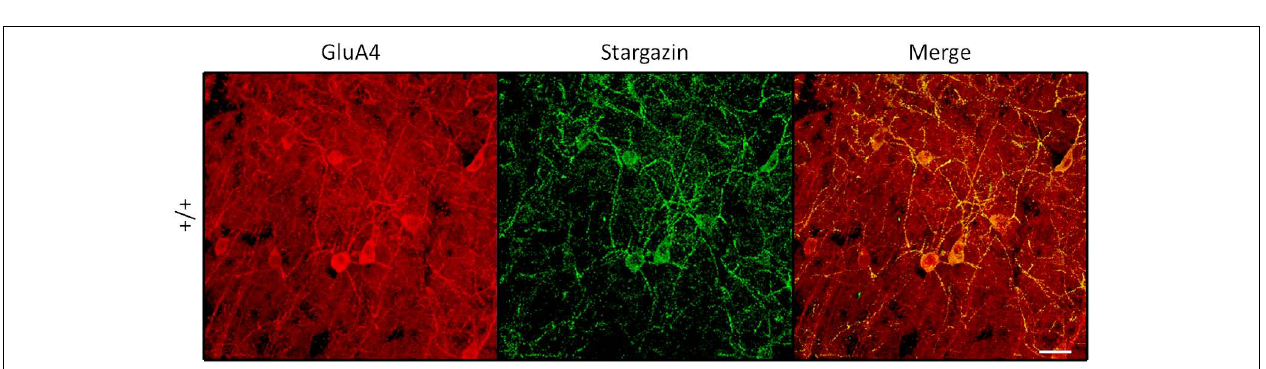
FIGURE 3 | Regional variation in stargazin immunoreactivity. In the hippocampal CA1 region, both PV + interneurons and pyramidal neurons (arrow) can express stargazin, whereas in frontal and occipital cortex, as in somatosensory regions, stargazin expression is limited to PV + /TdT + interneurons (scale = 10 μ m).